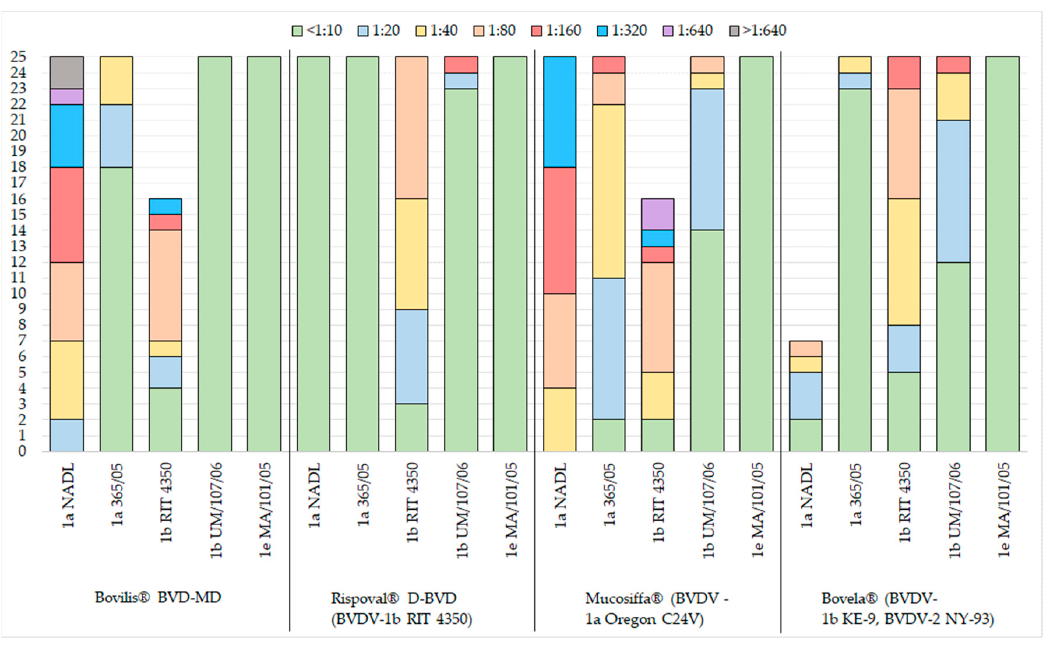
Figure 1. Results for distribution of inoculated vaccine and virus neutralisation in cattle for the 5 viral strains employed.